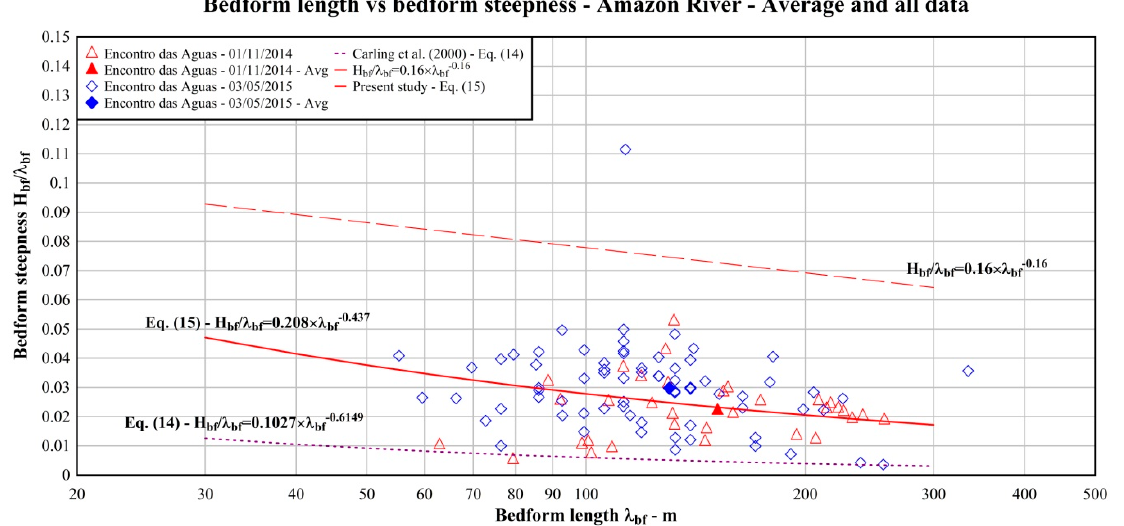
Figure 13. Bedform wavelength vs. bedform steepness.